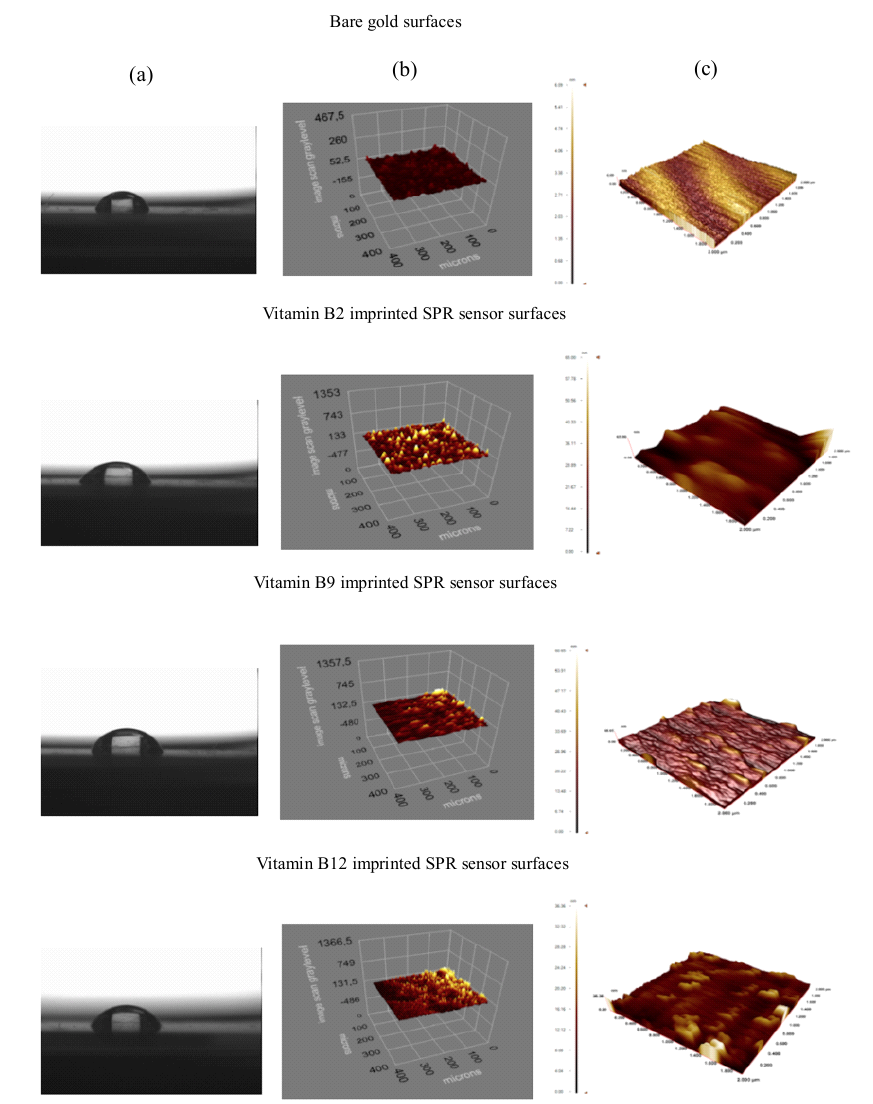
Fig. 4 Characterization of bare gold surface and vitamins B2, B9, and B12 imprinted SPR sensor surfaces [(a) contact angles, (b) ellipsometry images, and (c) AFM